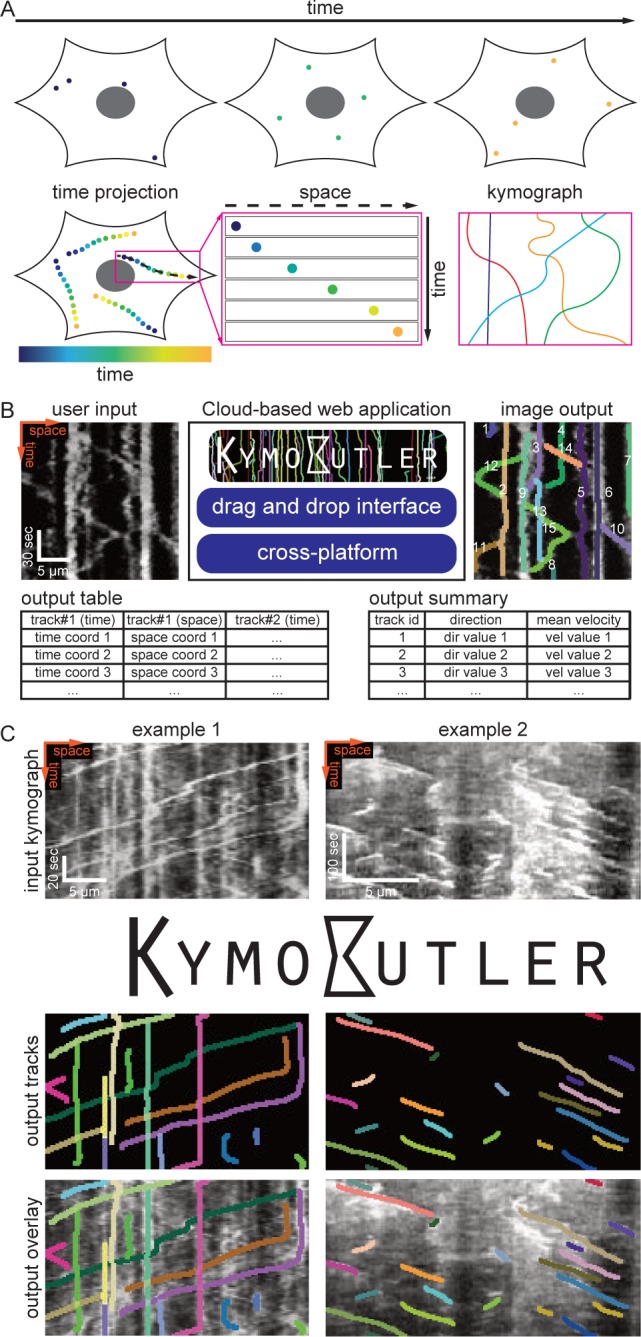
Kymograph generation and KymoButler.(A) Schematic of kymograph generation from live imaging data. A cell and four particles are shown at three different timepoints (top row). A temporal projection of this cell highlights how each particle moves along an individual path. If the cell does not move while the particle moves along this path, the path is called ‘stationary’. In this case one can draw a line (dashed black) along the path and extract the intensity of the particle in subsequent frames along this line. If one then stacks the intensity along this line into subsequent rows of a 2D image, where the horizontal and vertical axes represent space and time, the particle generates a line whose slope is indicative of the particle’s velocity. When multiple particles move along the same path, several lines will be visible in the kymograph image. (B) Functionality of KymoButler. A kymograph, here the motion of mitochondria along neuronal dendrites adapted from Faits et al. (2016), is uploaded via drag and drop to the cloud interface at http://kymobutler.deepmirror.ai, where the noise-dependent sensitivity can be manually adjusted. The outputs are: an overlay highlighting all the tracks found in different (random) colours, a. csv file with the time and space coordinates for each track, and a. csv file containing the summary of the direction and velocity of each track. (C) KymoButler image outputs from two example kymographs. Left: dynamics of fluorescently labelled Rab11a in rat cortical axons (adapted from Koseki et al., 2017; bidirectional movement as Rab11a can move both ways in the axon or become stationary). Right: dynamics of fluorescently labelled microtubule plus-ends in mouse dorsal root ganglion axons (adapted from Lazarus et al., 2013; unidirectional movement since microtubule growth is continuous). The top row depicts the raw kymographs as taken from the published manuscripts. The middle row shows the identified tracks as dilated coloured lines. The bottom row depicts an overlay of the raw kymograph with the KymoButler prediction. Further examples from published work are shown in Figure 1—figure supplement 1A.